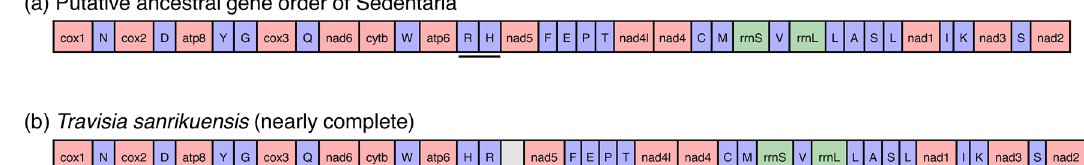
Figure 3. Gene order of the mitochondrial genome of ( a ) the putative ancestral gene order of Sedentaria (known for oligochaetes, leeches, and Siboglinidae) and ( b ) the nearly complete sequence of Travisia sanrikuensis . Red: protein-coding genes, Blue: tRNAs, Green: rRNAs, Gray: not determined. Underlines indicate gene order that differs between ( a ) and ( b